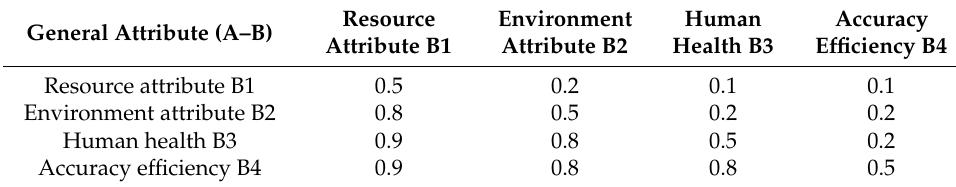
Table 4. Layer judgment matrix (A–B).